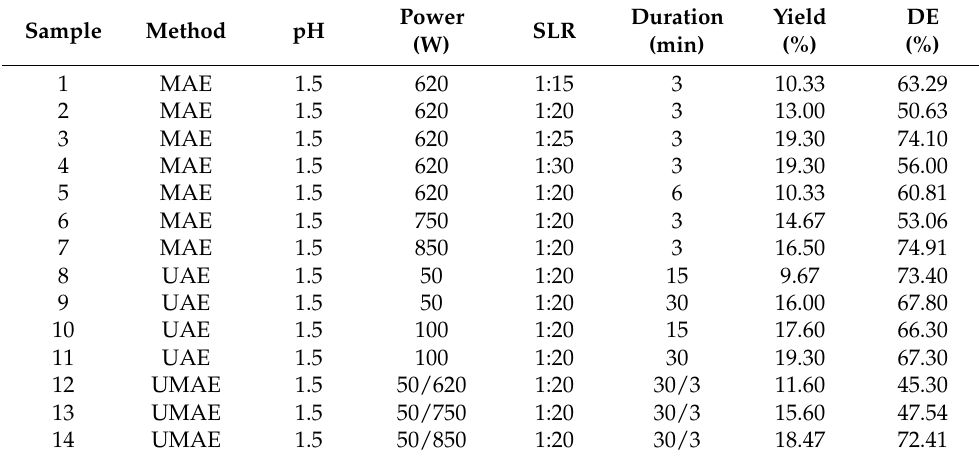
Table 1. Extraction conditions, yield (%) and degree of esterification (DE, %) for pectins extracted using ultrasound-assisted extraction (UAE), microwave-assisted extraction (MAE) or a combination of both ultrasound- and microwave-assisted extraction